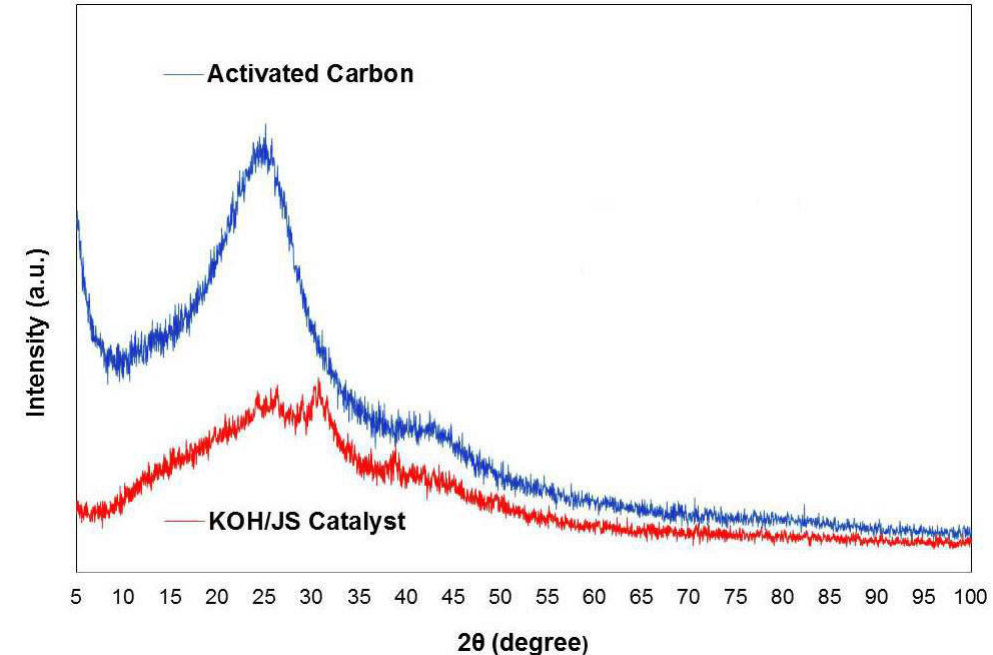
Figure 2. XRD patterns of activated carbon and Jatropha curcas fruit shell activated carbon (KOH/JS) catalyst.